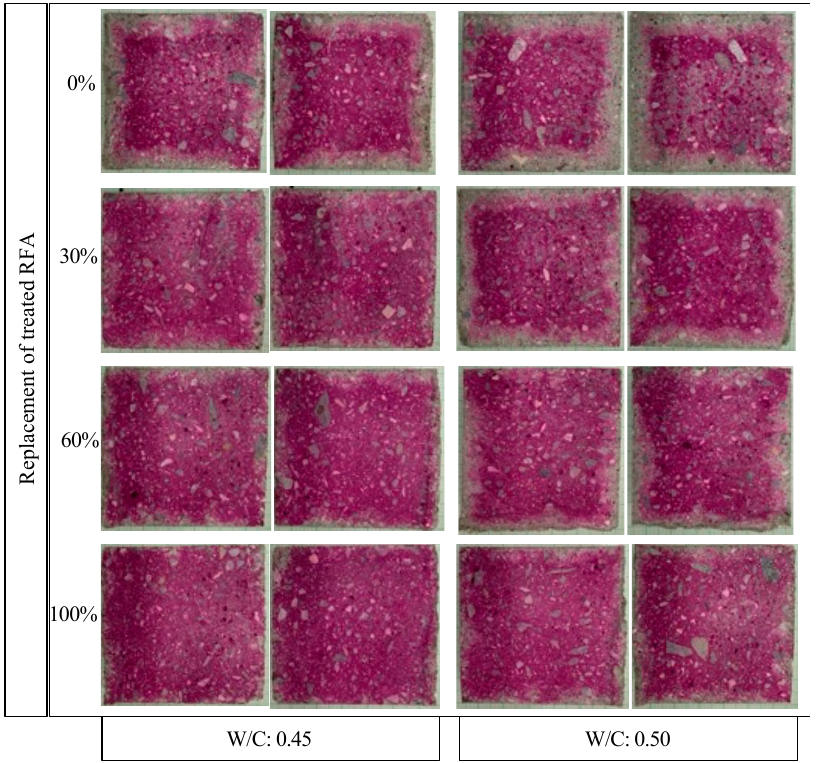
Figure 14. Carbonation front of mortar made with different replacement of treated RFA at 0.5 mol/L – 7d – 20 °C.